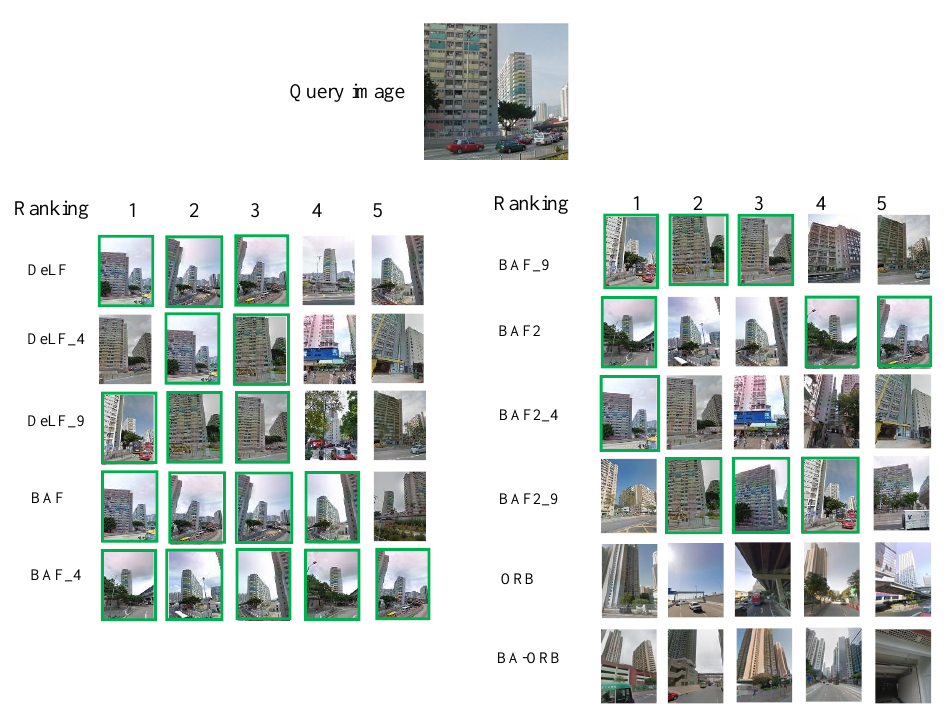
Figure 15. A street-level image queried in 11